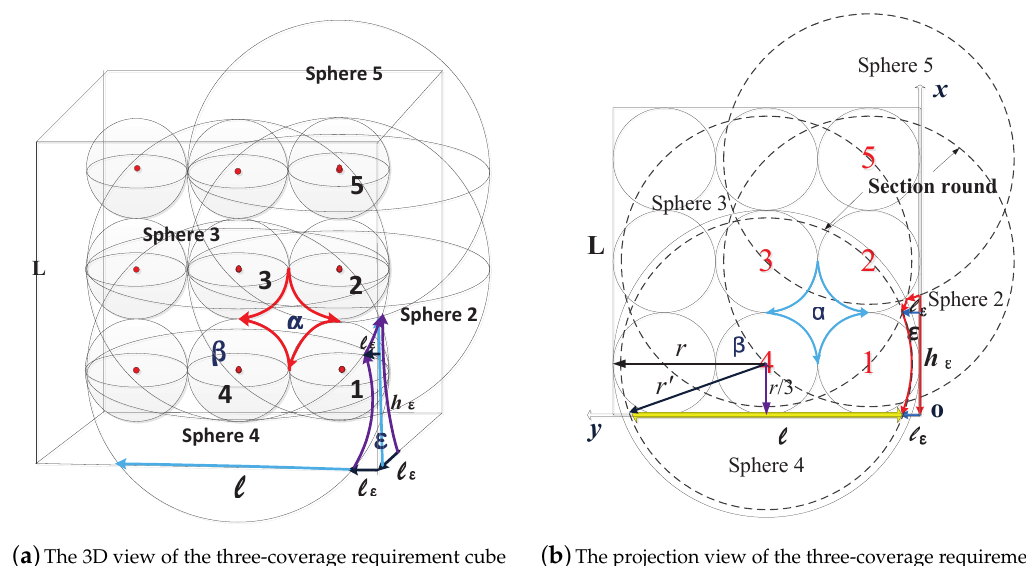
Figure A2. Critical case in the three-coverage requirement region. ( a ) The 3D view of the three-coverage requirement cube; ( b ) The projection view of the three-coverage requirement